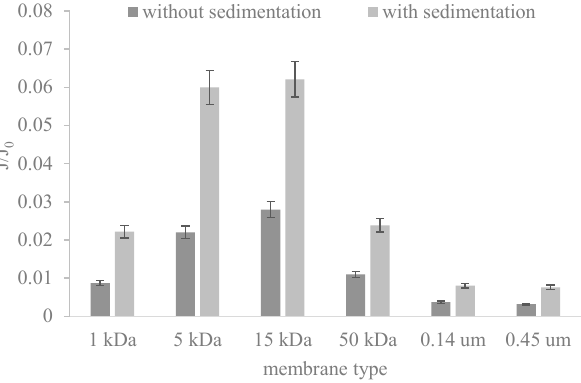
Figure 9. Influence of digestate pre-treatment on membrane relative permeability (TMP 0.3 MPa).